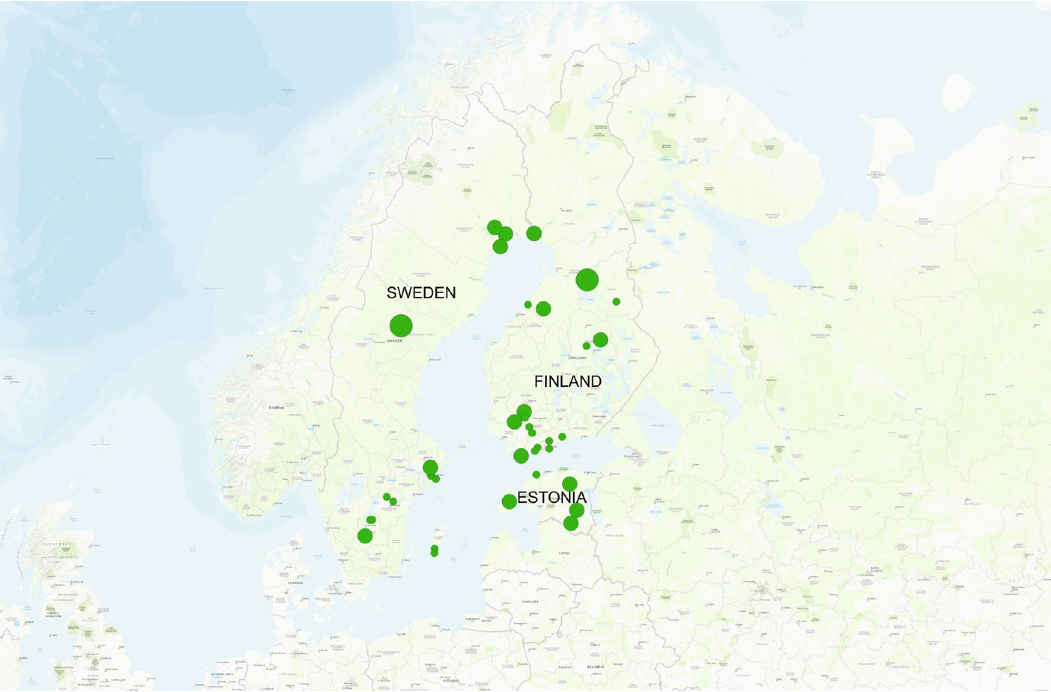
Figure 1. Map of the three northern Europe countries (Estonia, Finland, Sweden) from which honey samples were obtained. The size of the circles indicates the number of beekeepers the samples originate from, smallest circles indicating the honey samples originate from a single beekeeper and large circles from multiple beekeepers. The map was created with the program QGIS, version 3.10.4 (https